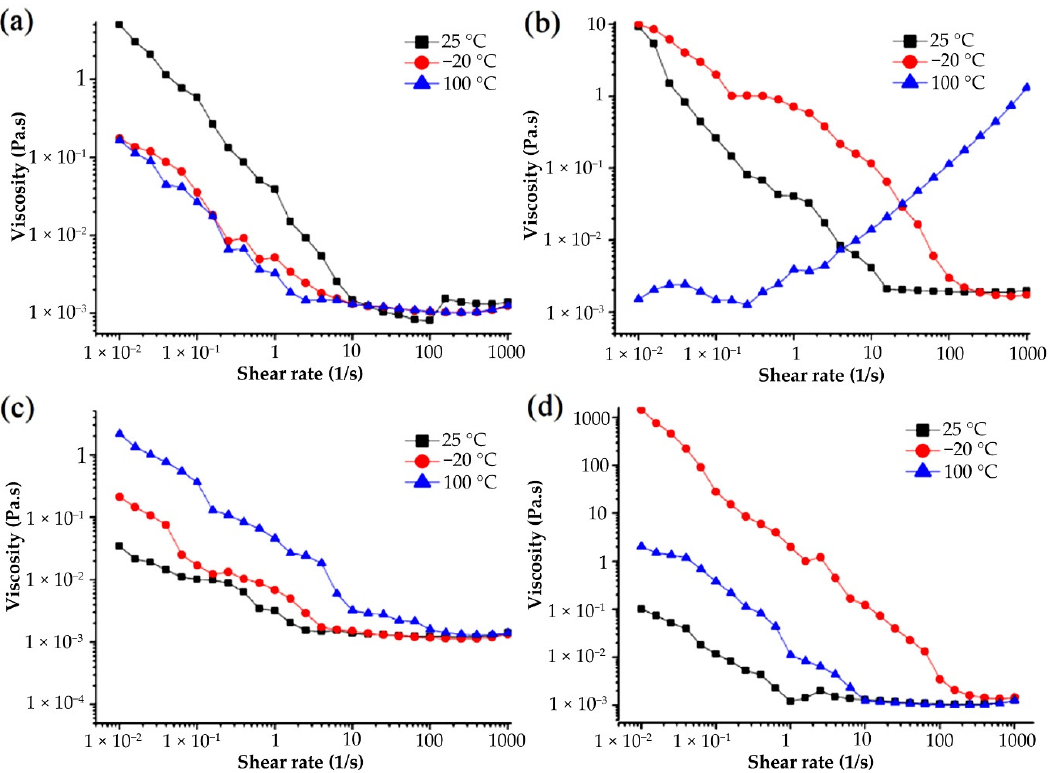
Figure 8. Effect of freezing and heating on the viscosity of G ‐ MLPs. ( a ) G ‐ HBSS; ( b ) G ‐ CHSS; ( c ) G ‐ DASS; ( d ) G ‐ CASS.